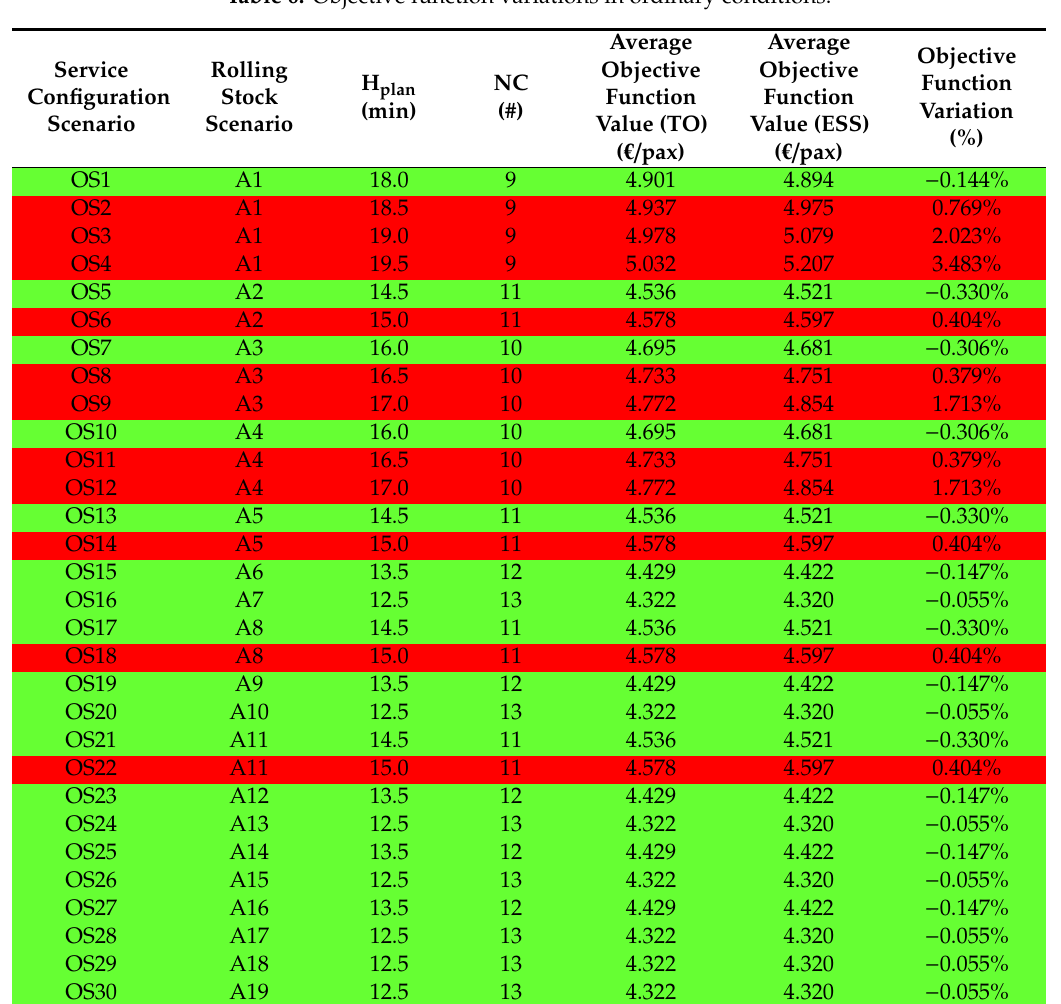
Table 6. Objective function variations in ordinary